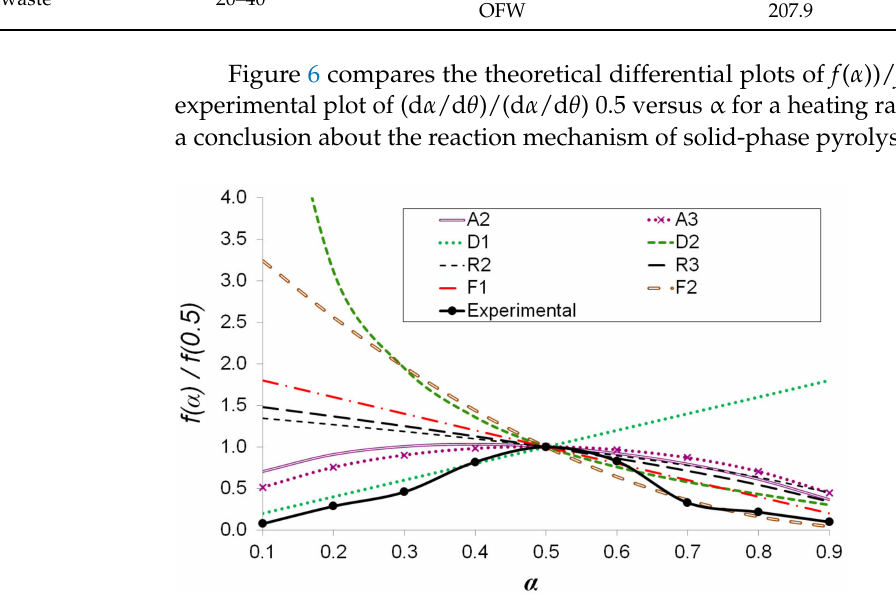
Figure 6. Comparison of experimental and theoretical master plots for samples